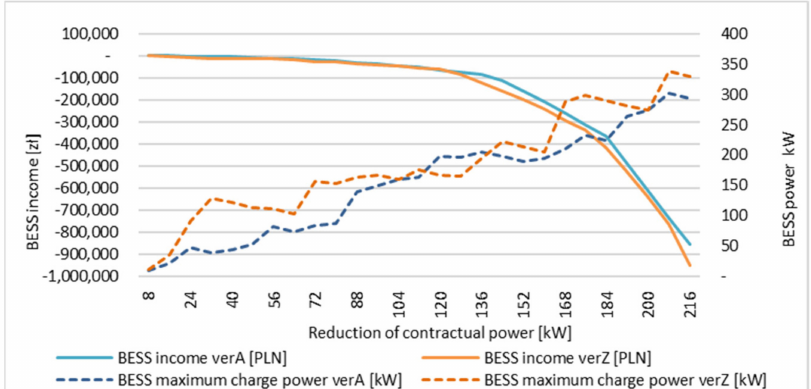
Figure 9. BESS revenue and BESS charging power as a function of the contractual power for C2019